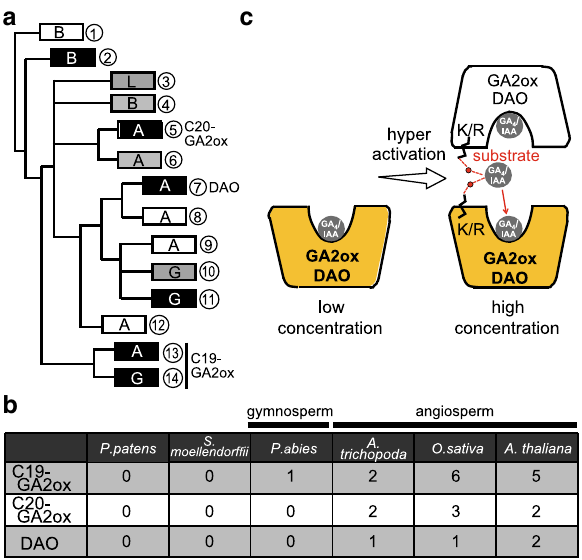
Fig. 5 Activation model of OsGA2oxs and OsDAO and phylogenetic analysis. a Schematic phylogenetic tree of C19- and C20-type GA2oxs and DAOs, including some 2ODD enzymes bearing close resemblance to these enzymes. Each box corresponds to each clade with the same number presented in Supplementary Fig. 10. Clades containing only 2ODD enzymes with R/K at the 308th position of OsGA2ox3 or not are shown in black or white, whereas clades including both types are shown in gray. Bryophytes, lycophytes, gymnosperms, and angiosperms are shown as B, L, G, and A characters, respectively. b The number of gene copies of C19- and C20- type GA2ox and DAO in P. patens (Bryophytes), S. moellendorf fi i (Lycophytes), P. abies (Gymnosperms), A. trichopoda (the most primitive lineage of Angiosperms), O. sativa (monocot), and A. thaliana (dicot). c Under low substrate concentration (GA 4 or IAA) (left), GA2ox or DAO functions as a monomer with low enzyme activity. At high substrate concentration (right), the interface GA 4 or IAA causes the formation of multimers by bridging two enzyme molecules, resulting in hyperactivation.